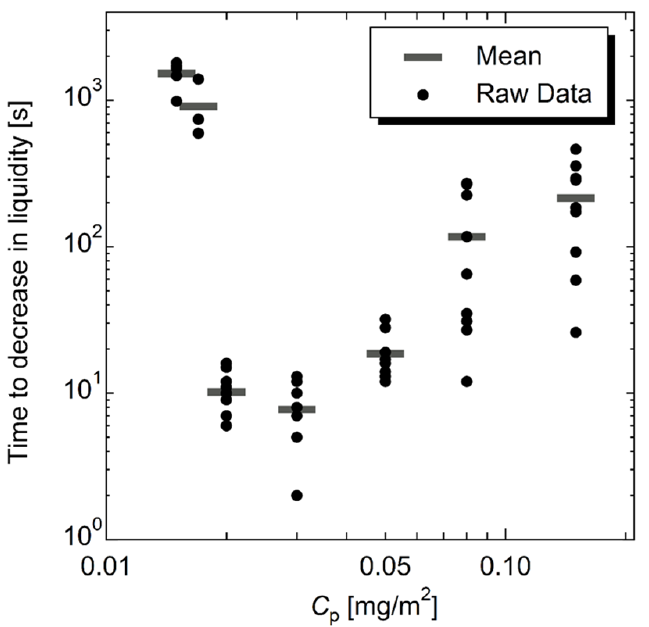
Figure 1. The time to decrease in liquidity was plotted against the value of C p (the amount of polymer dose per silica surface area). Horizontal bars represent the mean value. The PEO molecular weight was 1000 kg/mol.